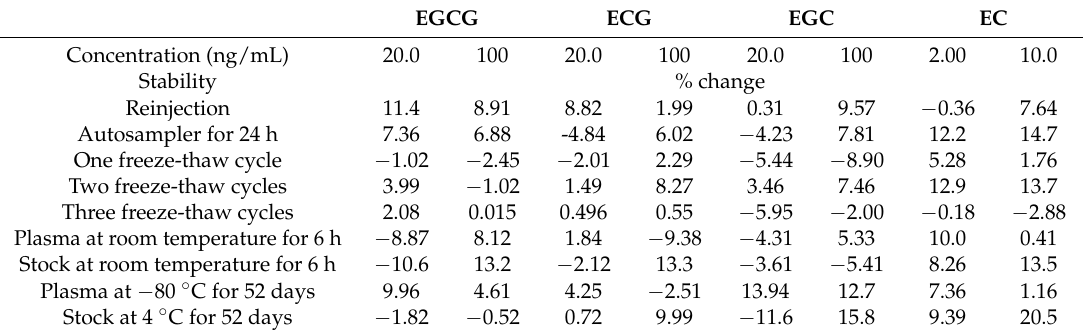
Table 2. The percentage of change difference in stability of epigallocatechin-3-gallate, epicatechin- 3-gallate, epigallocatechin, and epicatechin under various conditions at two concentrations ( n =